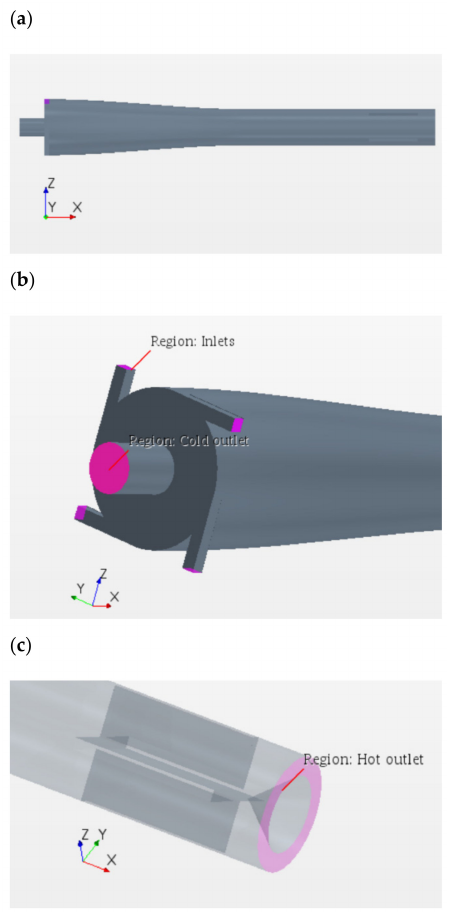
Figure 2. Geometry of the novel vortex tube: ( a ) side view; ( b ) region near inlets and cold outlet; ( c ), transparent view around hot outlet and de-twister.